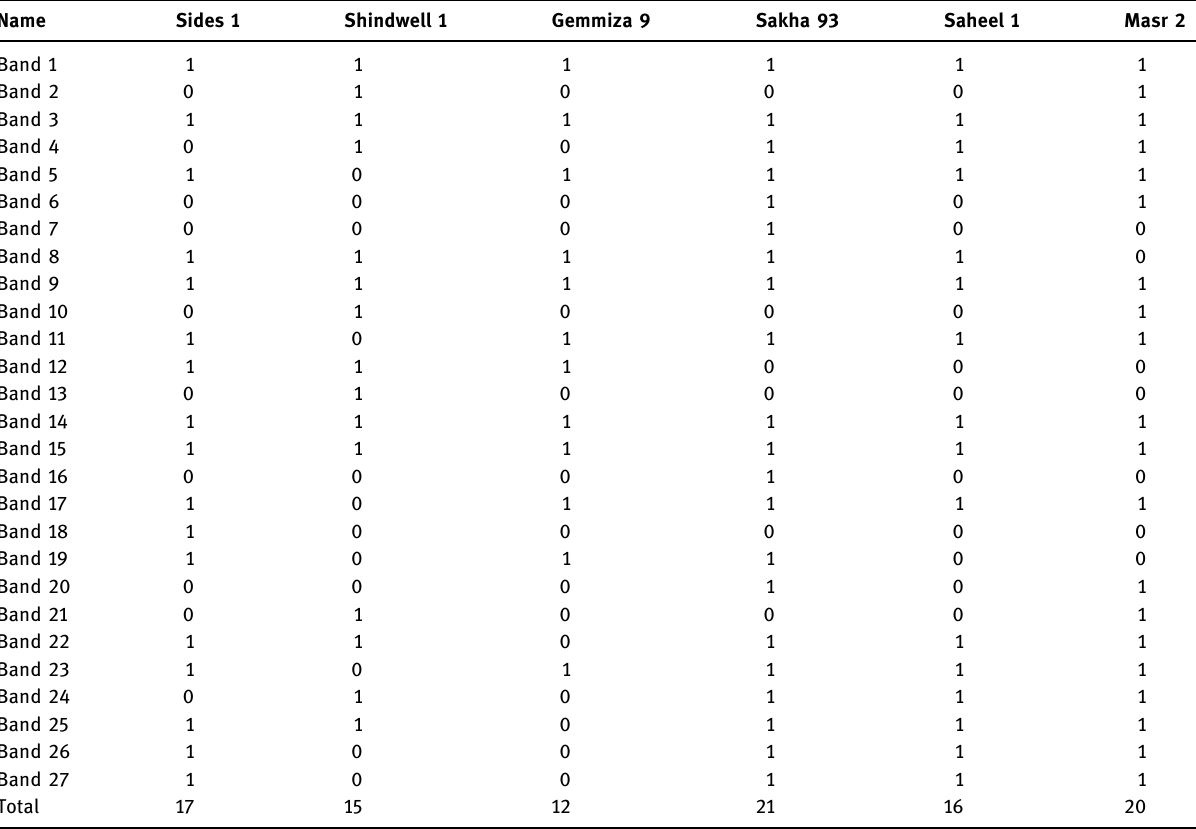
Table 3: Presence ( 1 ) versus absence ( 0 ) of PCR - ampli fi ed fragments from six wheat varieties using fi ve random primers Name